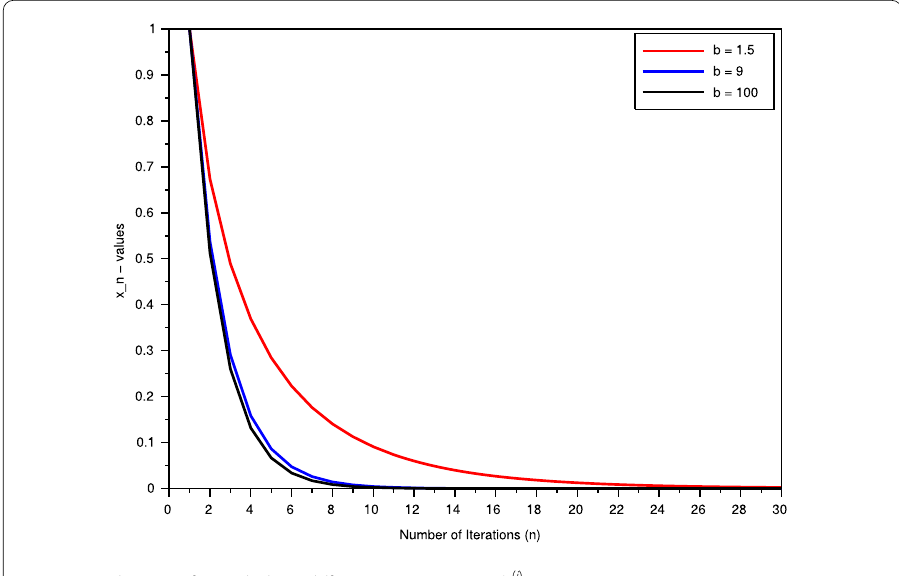
Figure 2 Behaviors of x n with three different parameters in { λ ( i ) n }